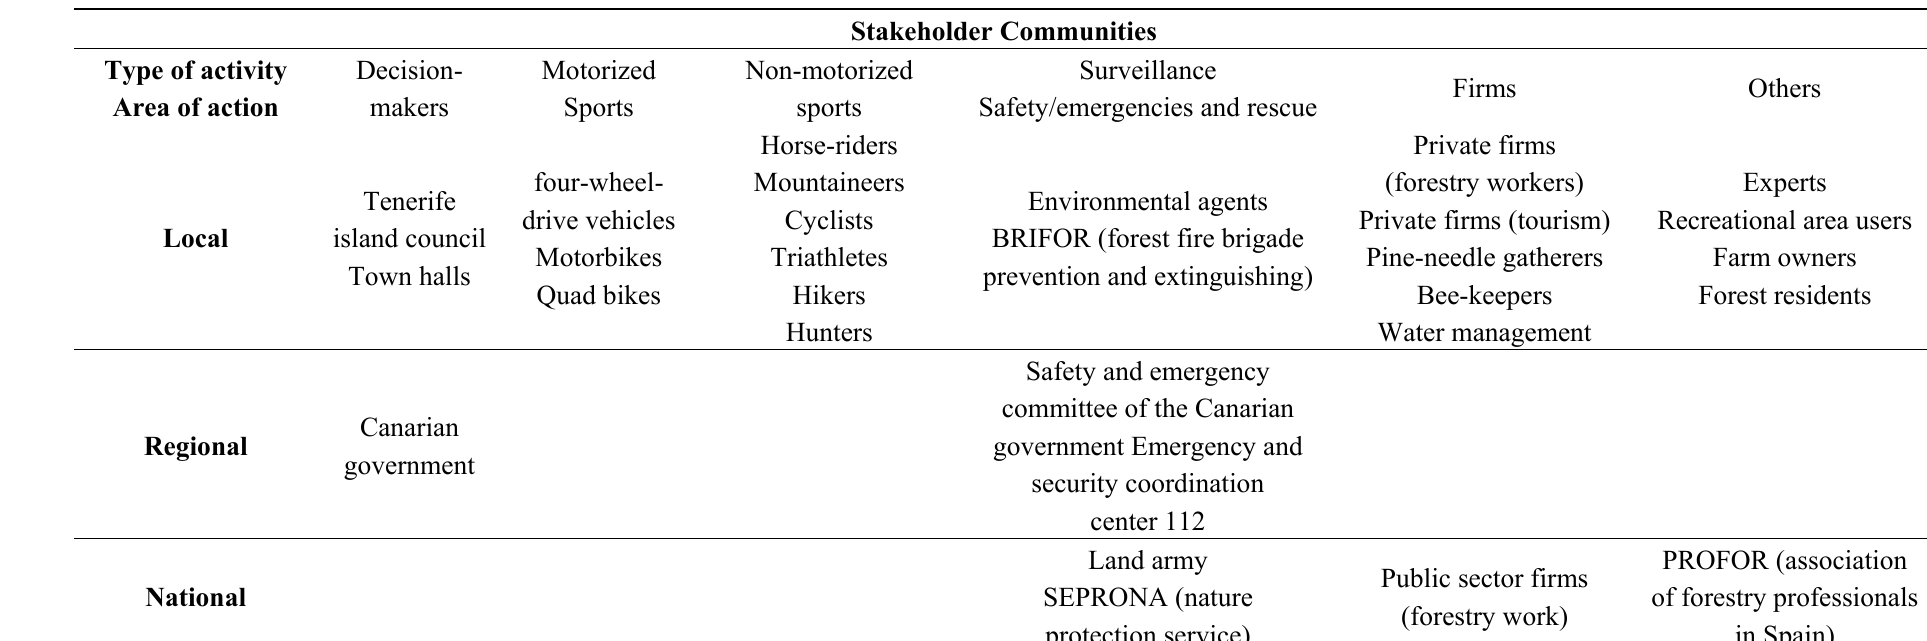
Table 2. Stakeholder communities according to their area of action and type of